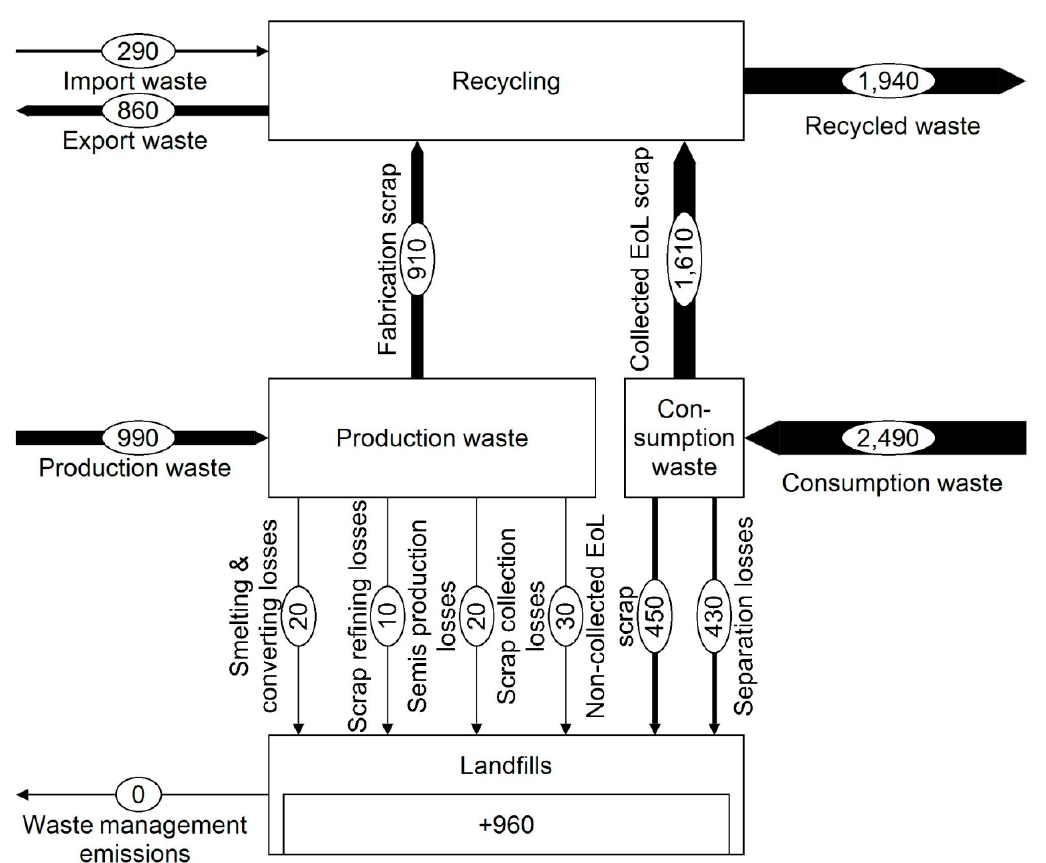
Figure A8. EU 28 Cu system 2014, subsystem waste management.